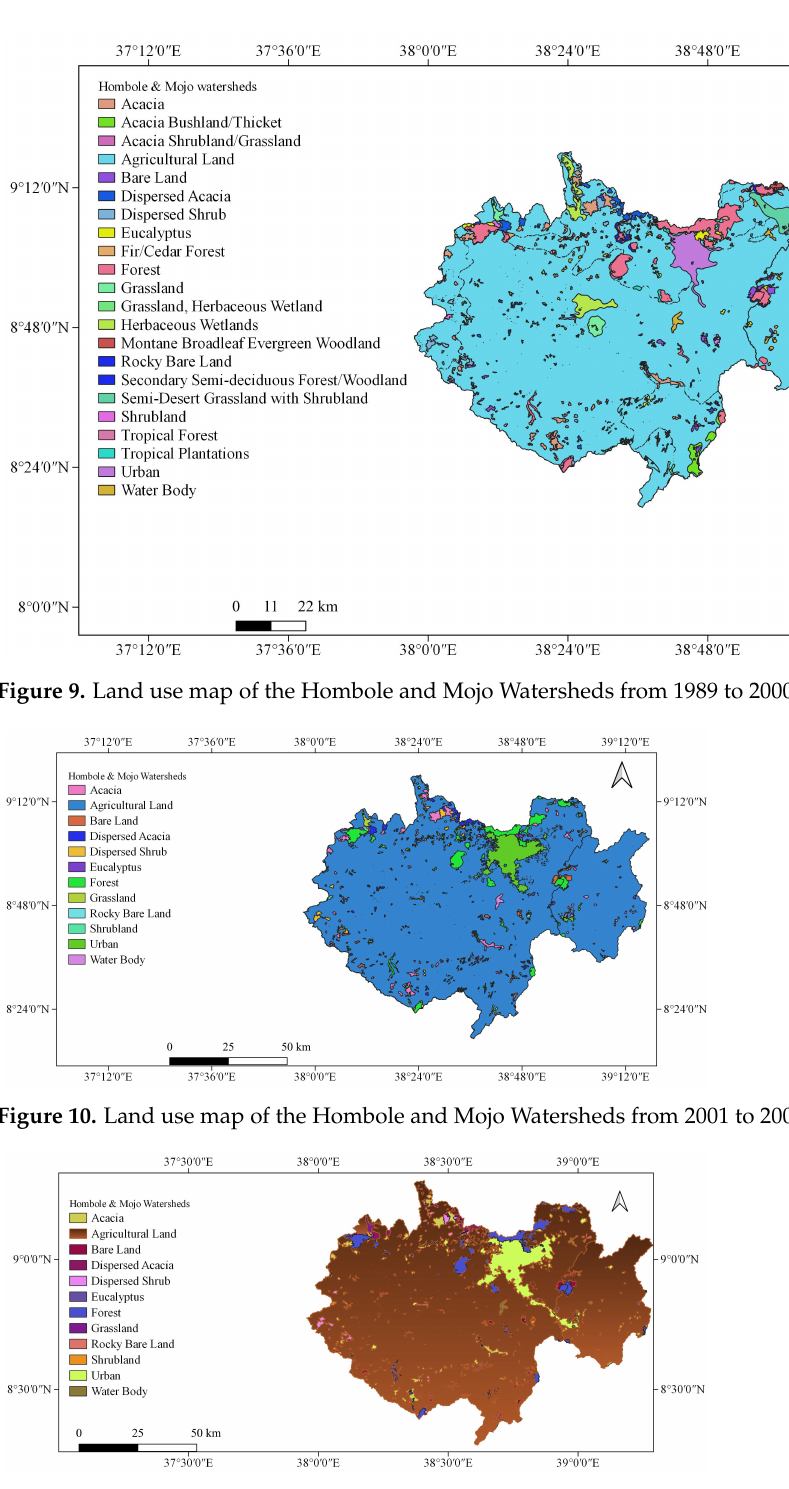
Figure 11. Land use map of the Hombole and Mojo Watersheds from 2009 to